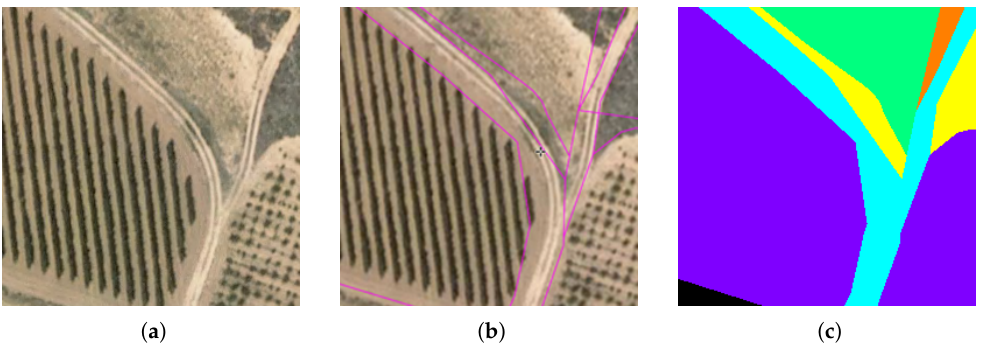
Figure 1. Cropped image and ground truth checking for UOPNOA. ( a ) cropped image of 256 × 256 pixels from a PNOA image, ( b ) SIGPAC visor of the same region to check the ground truth mask , ( c ) ground truth